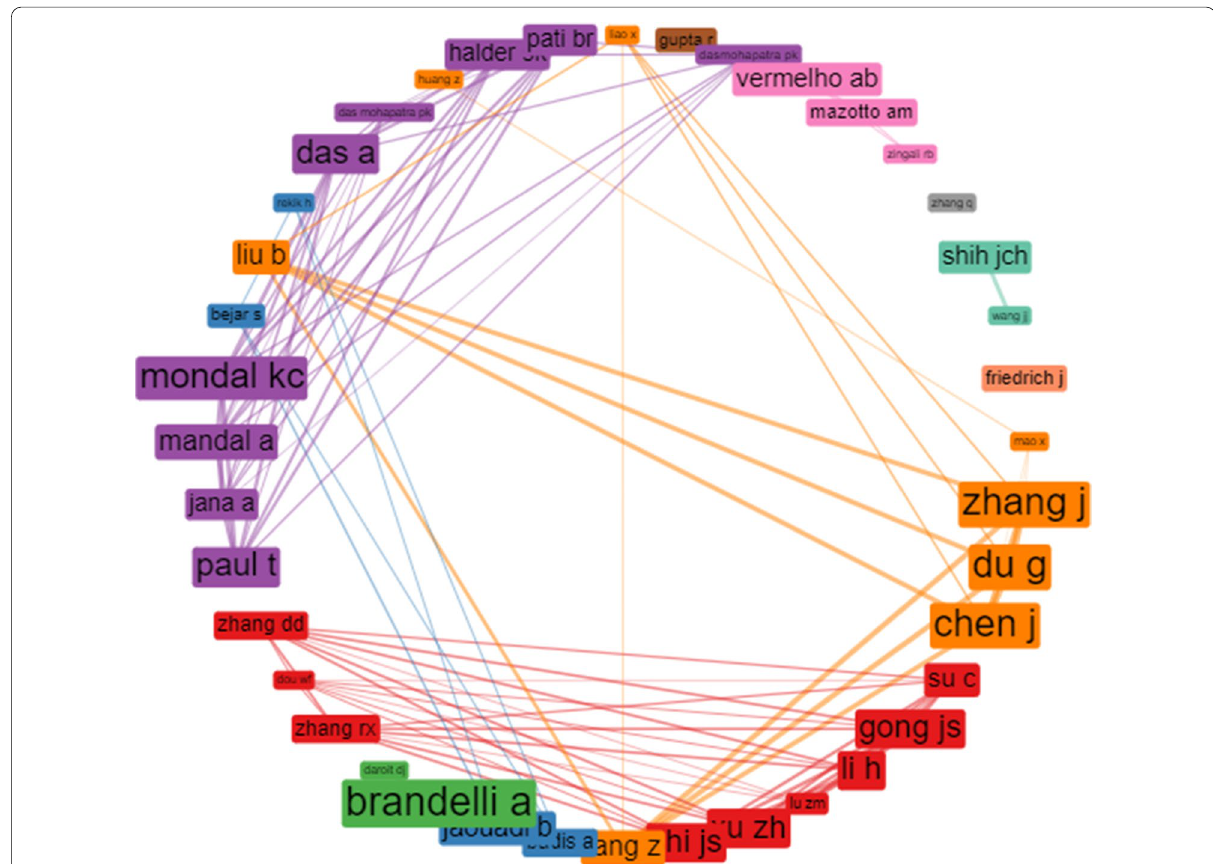
Fig. 2 The top forty authors’ collaboration network on keratinase research. Each node represents a single author, while the collaboration pathways are the connecting lines. The thickness of the lines indicates the strength of the